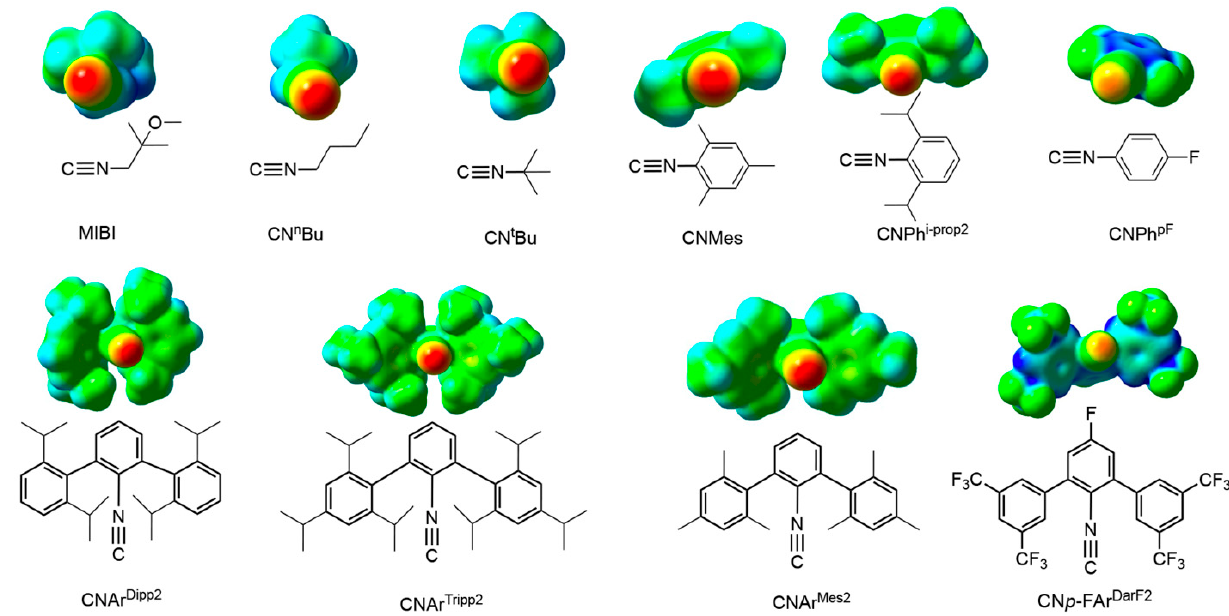
Figure 1. Isocyanides discussed in the present paper together with their electrostatic potential map- ping (MO = 0.02; ρ iso = 0.004) normalized to the potential boundaries of CNMe (7.478 × 10 − 2 [e/Å 3 ]; blue = positive, red = negative) [11].